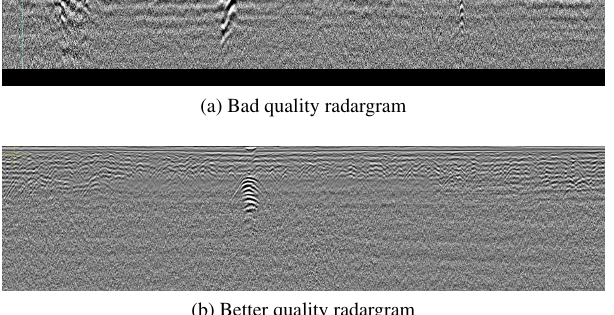
Figure 4. GPR signal are highly dependent on soil condition during signal transmission.